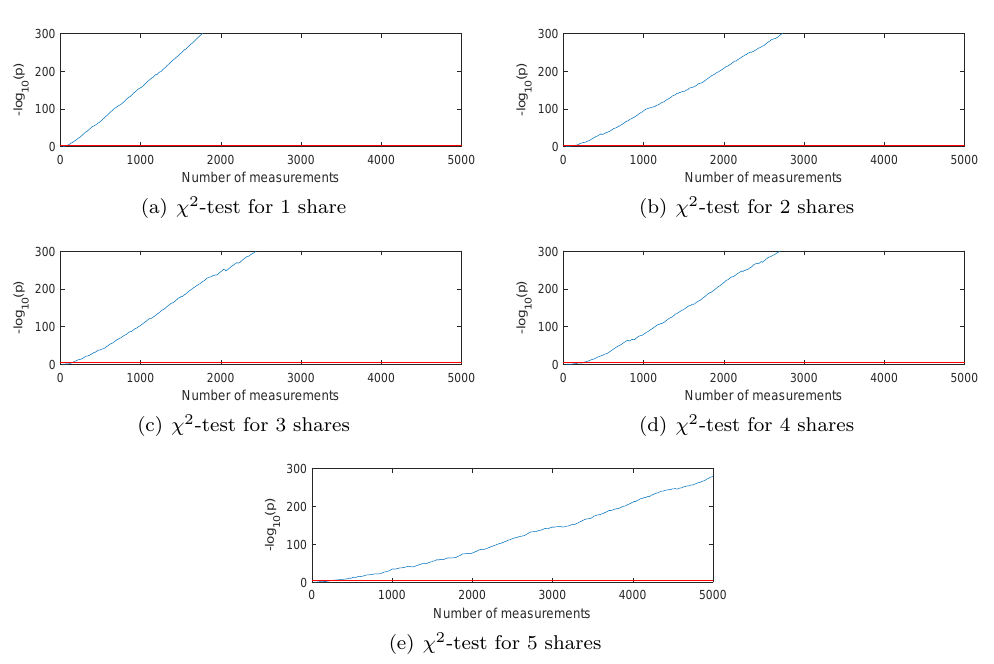
Figure 11: χ 2 -test results for the first 5,000 of the total 50,000 static power measurements of 1-bit of information shared among 1, 2, ..., 5 high-fanout register bits in 65 nm CMOS technology, recorded at 90 ◦ C and 1 . 6 V.